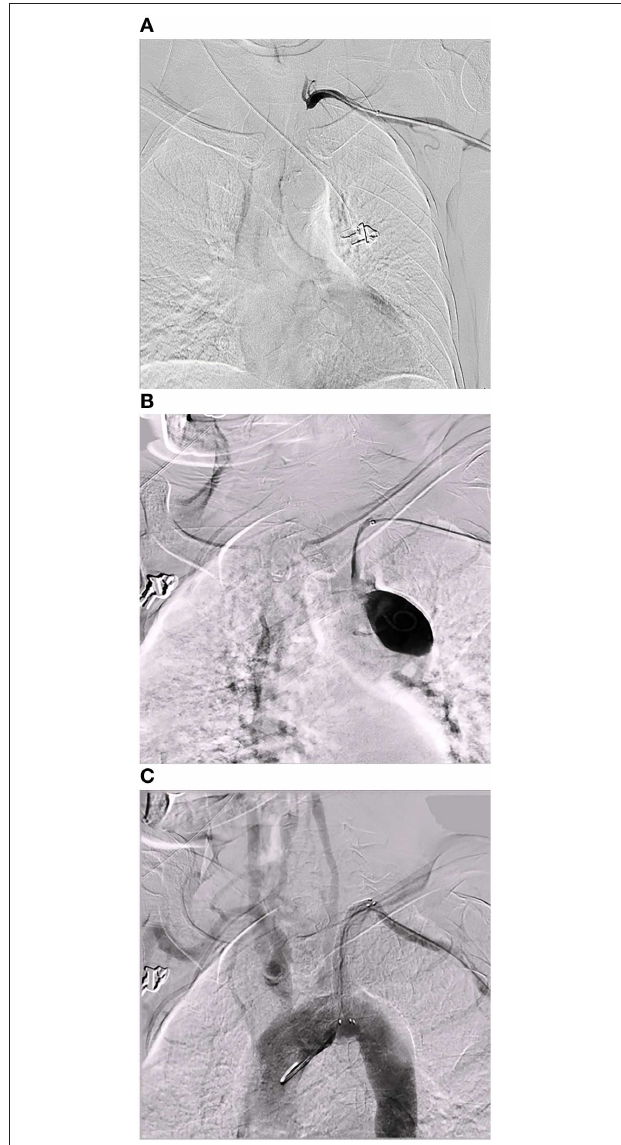
FIGURE 3 | An arterial dissection. A 70 year-old male patient who presented with vertigo and left arm claudication for 2 years. CTA of the lower extremity showed bilateral iliac artery occlusion. (A) Angiography revealed a long segment occlusion at the beginning of the left subclavian artery. (B) After passing a guidewire through the lesion via the retrograde approach through the left brachial artery, angiography revealed an arterial dissection from the proximal segment of the left subclavian artery to the aortic arch. (C) A covered stent was implanted to treat the dissection, but the blood flow of the left vertebral artery was